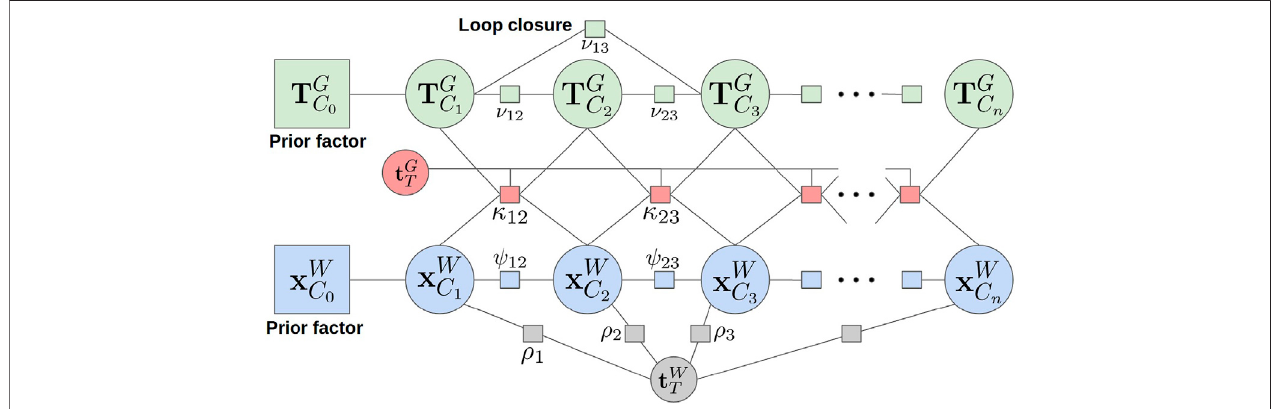
FIGURE 5 | The full factor graph used for Chaser and Target state estimation. Nodes represent pose variables and are connected by ToF camera pose odometry, IMU odometry, range/bearing measurements, and rotation kinematic factors.